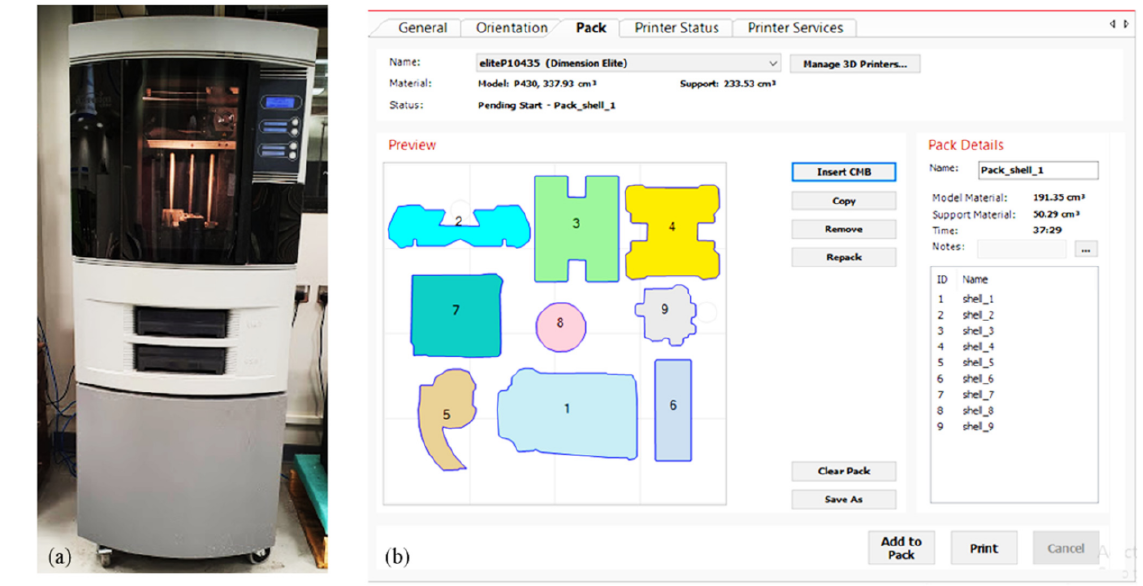
Figure 8. ( a ) Dimension Elite 3D printer (Courtesy: STRATASYS); ( b ) Component arrangement.